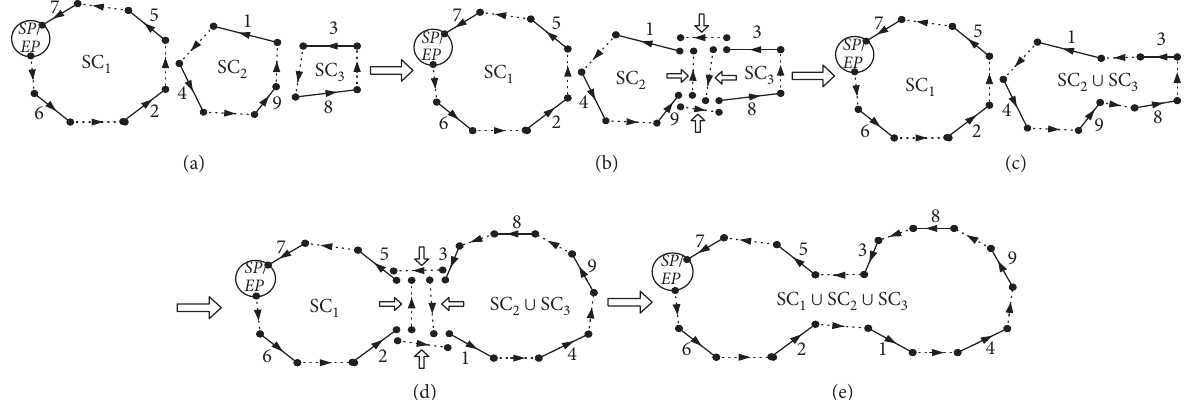
Figure 7: Equivalent merging process of subloops of the example shown in Table 3 (a) Three subloops determined by assignment. (b) Equivalent merging scheme. (c) New subloops after equivalent merging. (d) Minimum cost merging scheme. (e) Tour after minimum cost merging.